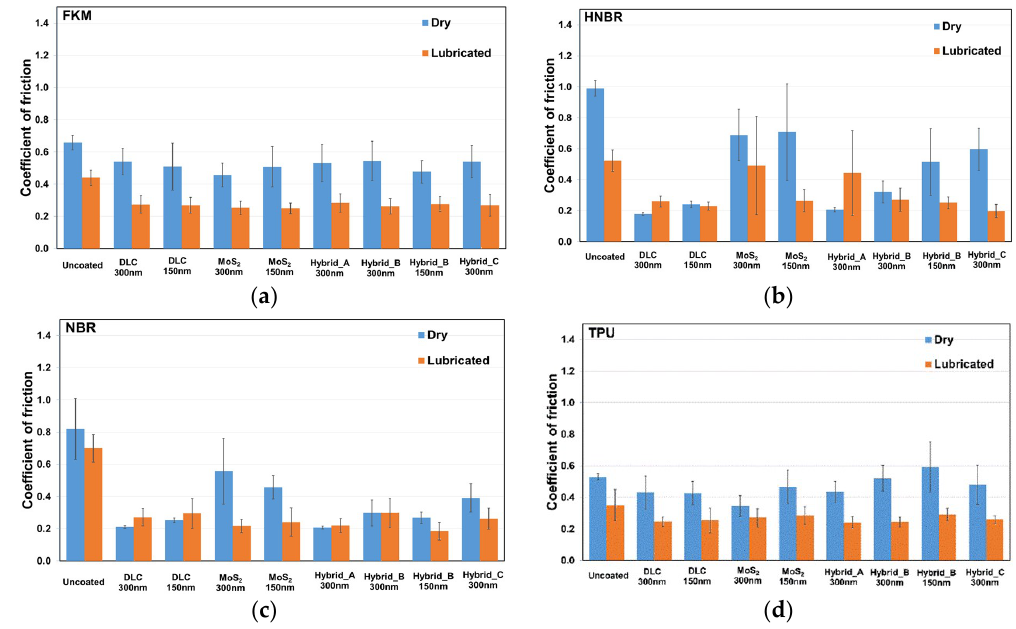
Figure 6. Coefficient of friction of uncoated and coated elastomers in dry and lubricated ball on disc